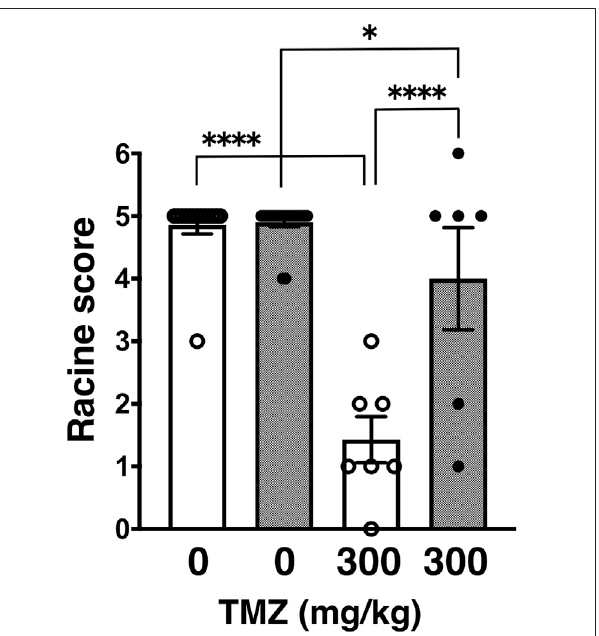
FIGURE2| Inhibitoryeffectsoftrimethadione(TMZ)onPTZ-evokedseizure. Effects of TMZ on occurrence of generalized tonic-clonic seizures. Seizure scores of adult male wild-type (white dots and white bars) and GluA1C811S (black dots and hashed bars) mice received an administration of TMZ at a dose of 0 or 300 mg/kg, 30 min before a single injection of 60 mg/kg PTZ. Four bars: n (cid:1) 14, 20, 7, 6 mice (left to right). Error bars represent s.e.m. ANOVA with Fisher ’ s LSD post hoc test. * p < 0.05, **** p <